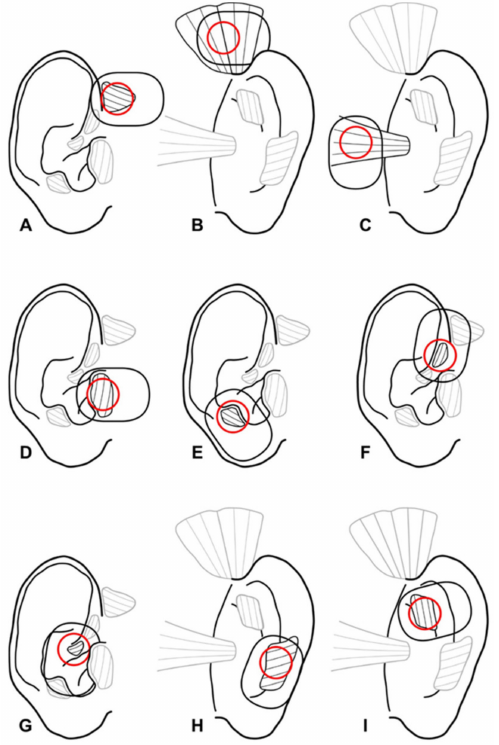
Figure 1. Localization of the extrinsic and intrinsic ear muscles for EMG analysis. ( A ): M. auricularis anterior. ( B ): M. auricularis superior. ( C ): M. auricularis posterior. ( D ): M. tragicus. ( E ): M. anti- tragicus. ( F ): M. helicis major. ( G ): M. helicis minor. ( H ): M. obliquus auriculae. ( I ): M. transversus